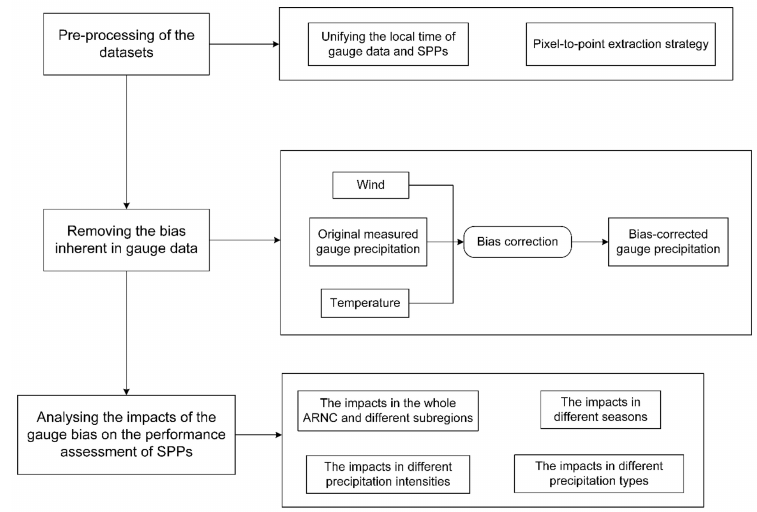
Figure 2. The flowchart of this